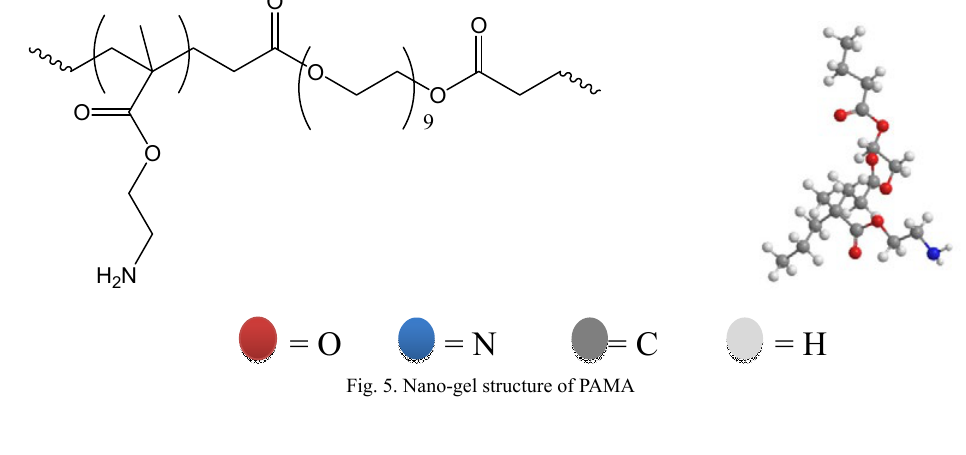
Fig. 5. Nano-gel structure of Fig.5 Nano-gel structure of PAMA